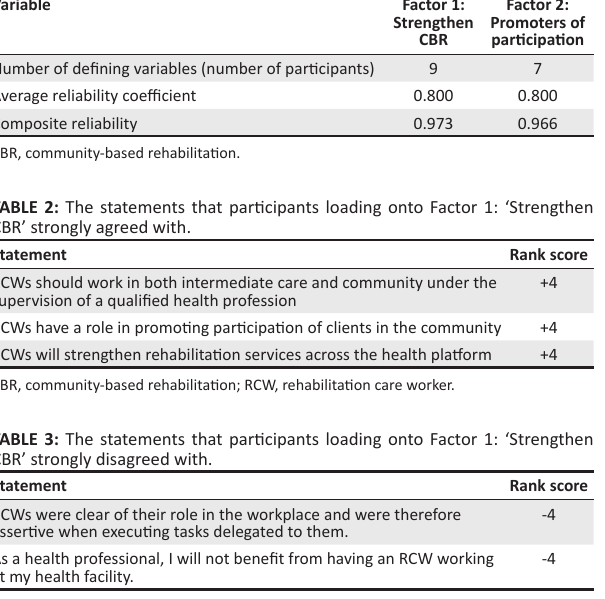
TABLE 1: Number of factors identified and the number of participants loading onto each factor.